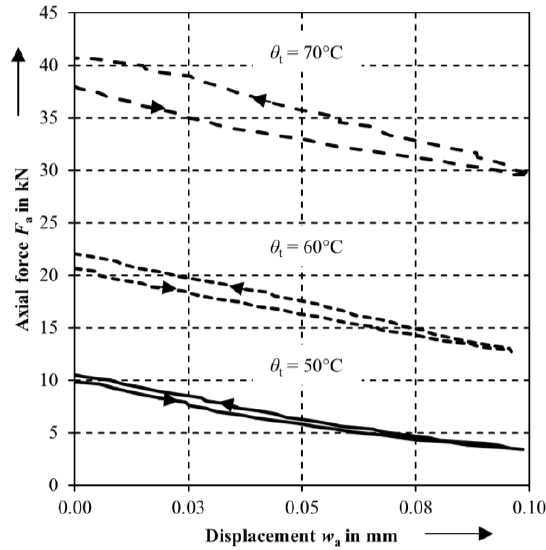
Figure 11. Axial force displacement diagram for the actuator without cylinder.